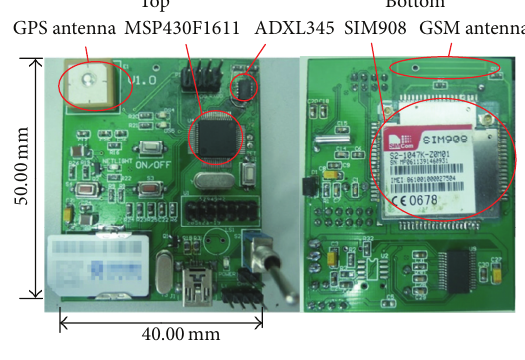
Figure 7: PCB board prototype.